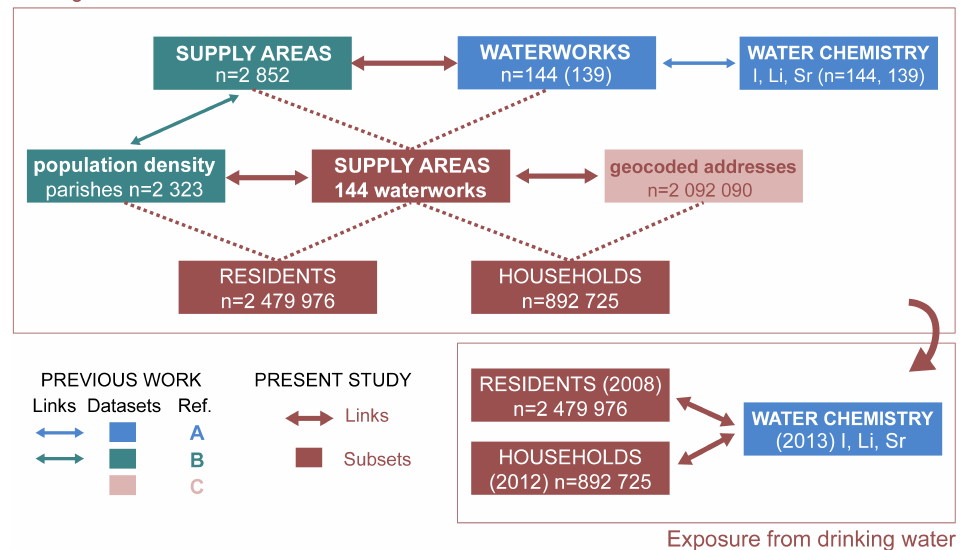
Figure 2. Scheme presenting the datasets, their subsets, and the links between them used